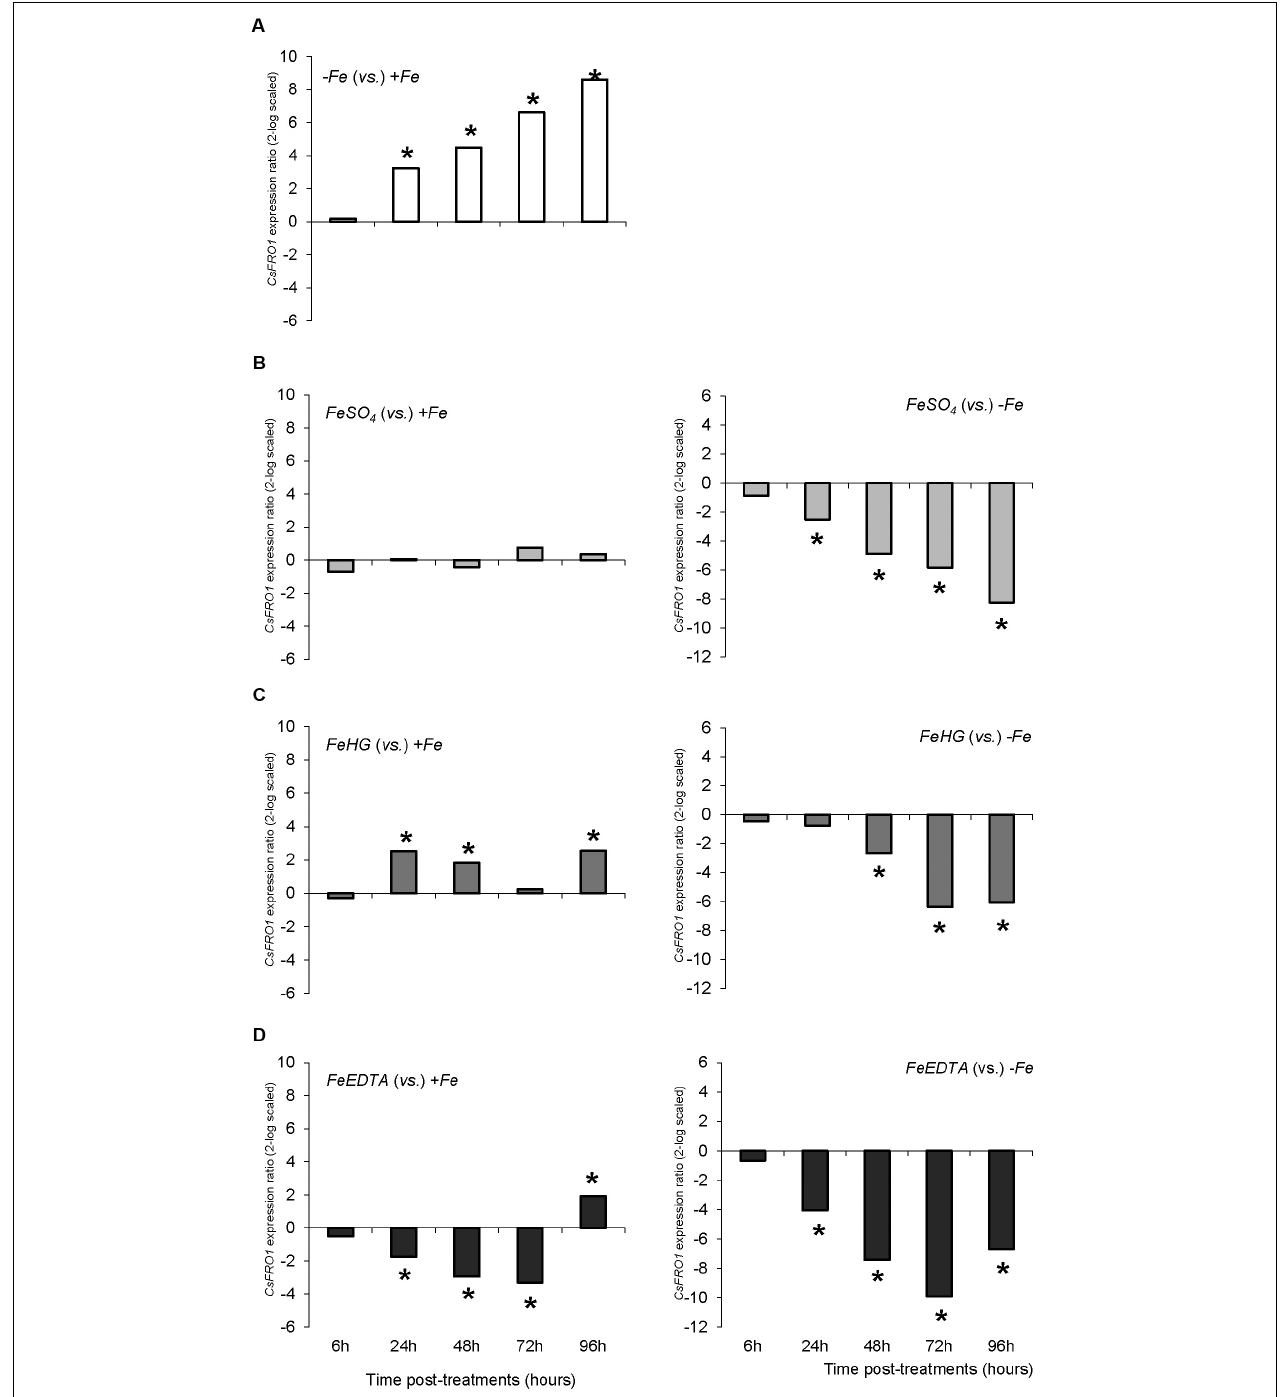
FIGURE 6 | CsFRO1 expression results in cucumber roots from Experiment II. Plants were grown in a nutrient solution with 5 µ M Fe, and then some of them were transferred to nutrient solutions with 40 µ M Fe (+ Fe ). The rest were transferred to nutrient solutions without Fe (– Fe ). A fourth of the – Fe plants received no further treatments in order to function as a deficient control. The rest of the plants received a total amount of 2.54 mg Fe/plant (divided into a 3-day application) of one of the following treatments: FeSO 4 , 3 mM FeSO 4 ; Fe-HG , 3 mM Fe(III)-heptagluconate; Fe-EDTA , 3 mM Fe(III)-EDTA. (A) Expression of CsFRO1 in root of – Fe plants versus + Fe plants. (B) Expression of CsFRO1 in root of FeSO 4 plants versus + Fe (left) and – Fe (right) plants. (C) Expression of CsFRO1 in root of Fe-HG plants versus + Fe (left) and – Fe (right) plants. (D) Expression of CsFRO1 in root of Fe-EDTA plants versus + Fe (left) and – Fe (right) plants. Data are means ± SE ( n = 5). Asterisks indicate significant differences between treatments at P < 0.05 based on one-way ANOVA and Fisher’s post hoc test. Statistical analysis of relative gene expression results was assessed using P-pairwise fixed reallocation randomization test.